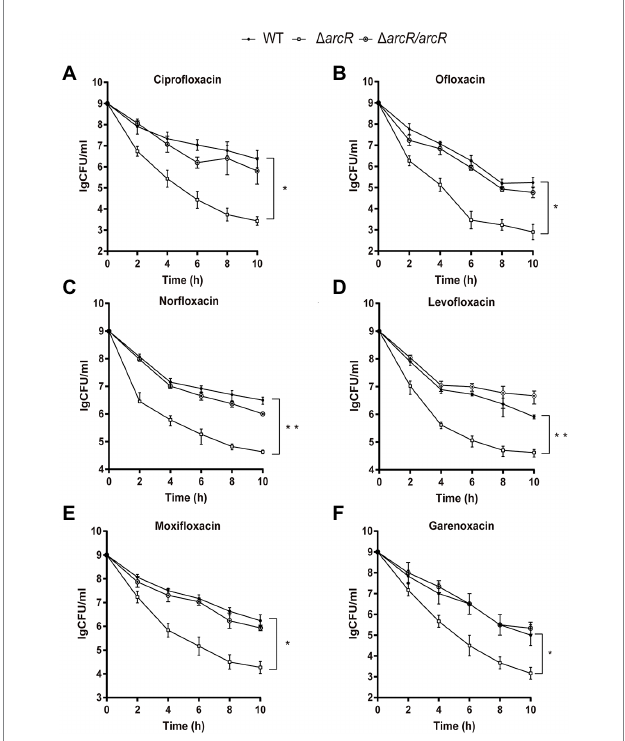
FIGURE 1 Roles of ArcR in bacterial resistance to fluoroquinolone antibiotics. Bacteria at OD 600 1.0 were treated with (A) 0.32 μ g/ml ciprofloxacin, (B) 0.5 μ g/ml ofloxacin, (C) 0.5 μ g/ml norfloxacin, (D) 0.5 μ g/ml levofloxacin, (E) 0.2 μ g/ml moxifloxacin, or (F) 0.06 μ g/ml garenoxacin in TSB at 37 ° C with agitation. Bacteria were collected at indicated times, and CFUs were determined by serial dilution and plating. Δ arcR / arcR represented the complementary strain, pCN51- arcR in Δ arcR mutant. Error bars represent standard deviations. The data represent results from three independent experiments. * p < 0.05, ** p < 0.01, and *** p < 0.001, by Student’s t -test.